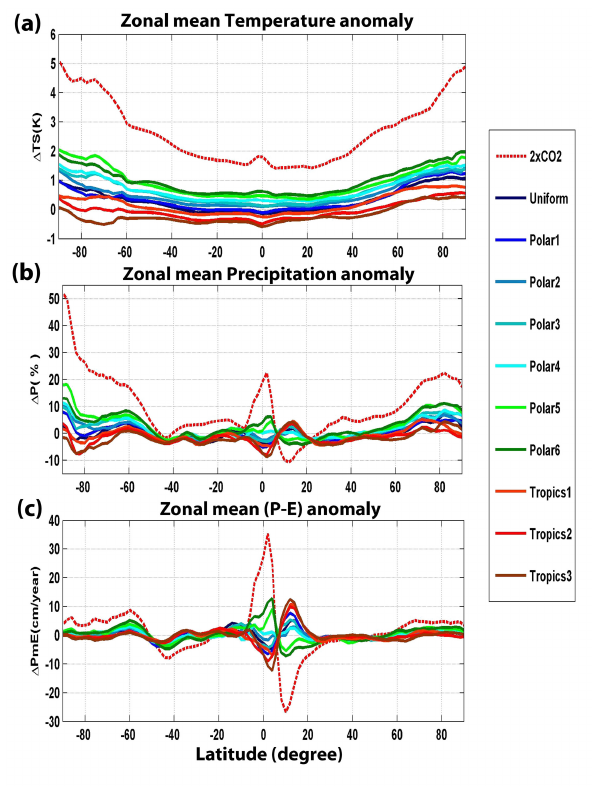
Figure 5. Zonal means of change in surface temperature ( 1 TS), precipitation ( 1 P) and precipitation minus evaporation ( 1 PmE). (a) Zonal mean 1 TS increases monotonically with increase in max- imum concentrations over the poles and decreases with increase in tropical maxima. (b) Zonal mean 1 P: polar maximum causes enhanced precipitation. (c) Zonal mean 1 PmE; polar maximum causes enhanced precipitation minus evaporation. Results shown are averages of the last 30 years of 60-year simulations.